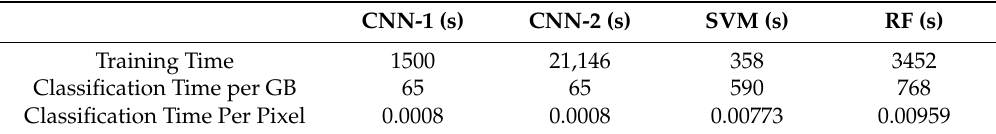
Table A2. Classifier training and classification times in seconds for three season data. For CNN, (1) initial steady-state validation accuracy; and (2) a 4-mil epoch standard training session. The CNN classifier utilized GPU-based processing, while SVM and RF were restricted to CPU-based processing.